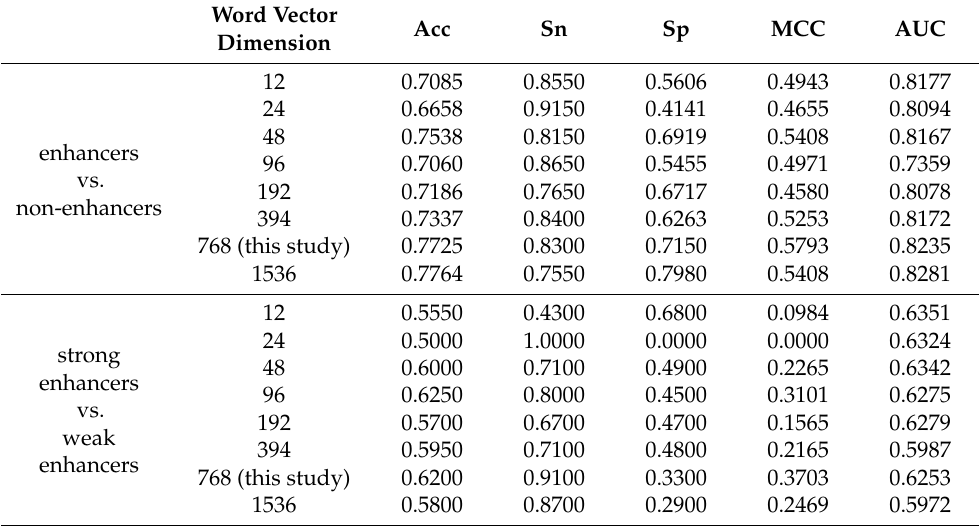
Table 6. Comparison of the spEnhancer model performances using different dimensions of word vectors on the independent test dataset. The first column gives the binary classification problem. The column “WV” is the dimension of the word vector. The other five columns give the prediction performances Acc, Sn, Sp, MCC, and